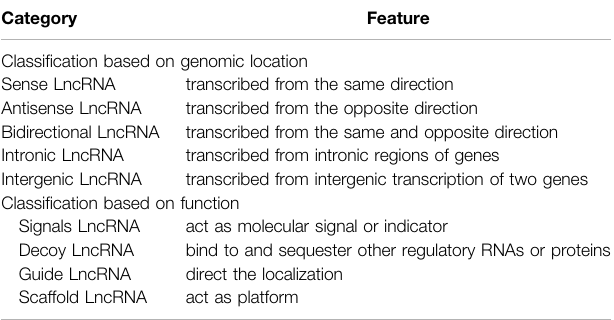
TABLE 1 | Two classi fi cation kinds of